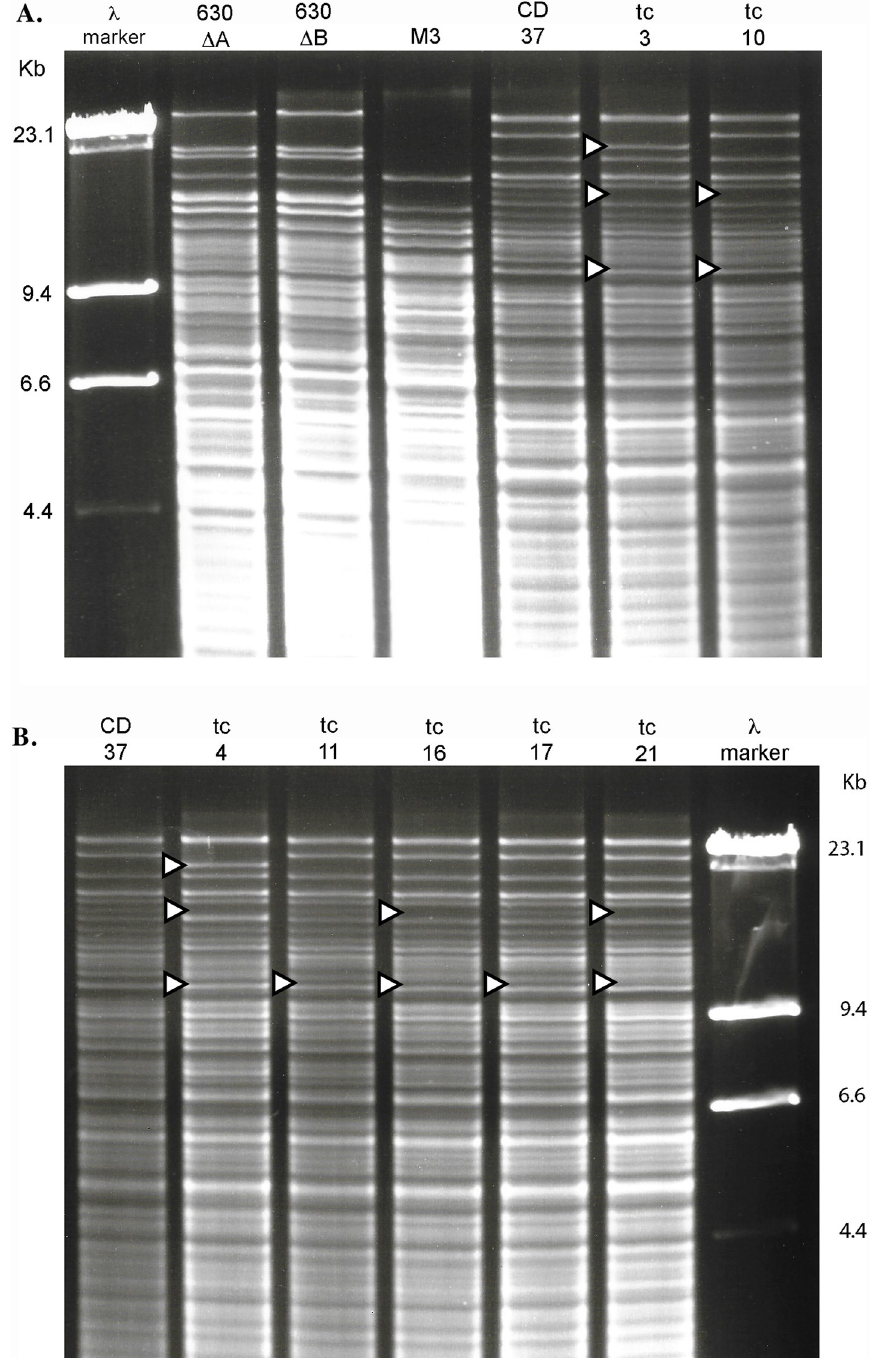
Fig 1. Hin dIII REA patterns of C . difficile donor (Strain 630 Δ erm), recipient strains (M3r, CD37), and seven representative CD37 transconjugants (tc). A . Lane 1; lambda DNA phage marker followed by donor strains 630 Δ tcd A, 630 Δ tcd B, M3, CD37, and transconjugants tc3 and tc10. B . Lane 1; CD37, followed by tc4, tc11, tc16, tc17, tc21 and lambda DNA phage marker. White arrowheads to the left of the gel lanes indicate Hin dIII band differences between parent strain CD37 (REA type T18) and CD37 transconjugants (tc3 –tc21).